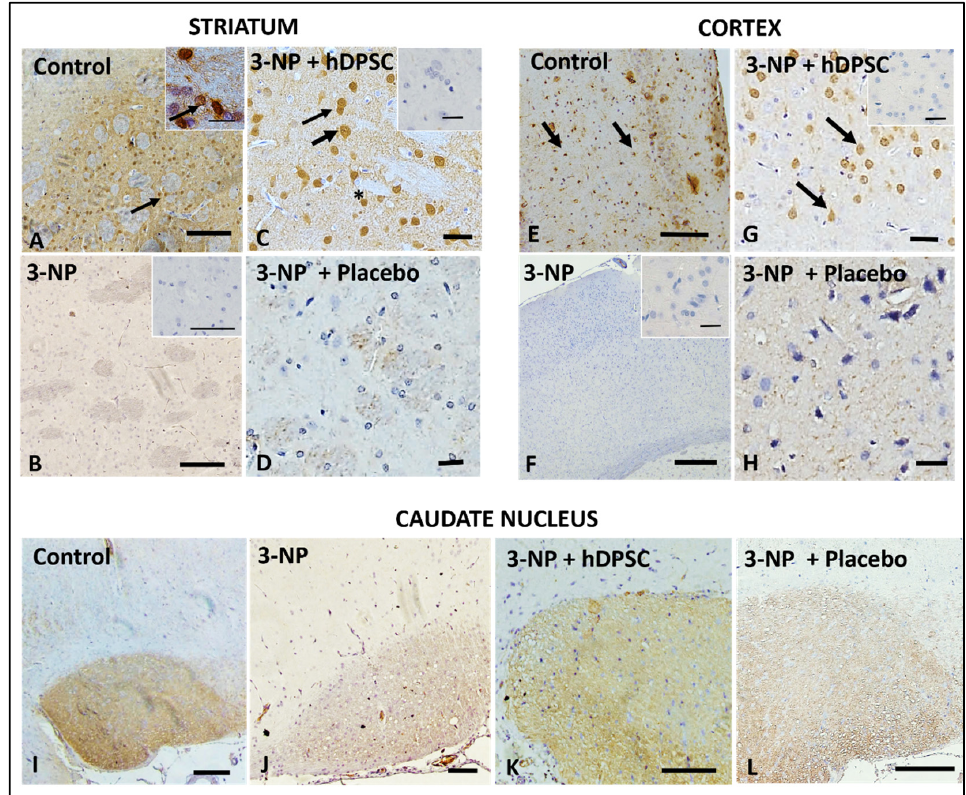
Figure 5. Expression of anti-BDNF antibody (black arrows) in the striatum ( A – D ), cortex ( E – H ) and caudate nucleus ( I – L ) in control ( A , E , I ); 3-NP ( B , F , J ), 3-NP + hIDPSC ( C , G , K ) and 3-NP + placebo animals ( D , H , L ), respectively. Insets in ( A – C , F , G ) show negative control (secondary antibody). Black arrows indicate BDNF expressing cells. Sections are contra-stained with HE. Scale bars: 50 µ m ( A , B , E , F , I – L ) and 100 µ m ( C , D , G , H ). Analysis performed 30 days after (D35) the treatment). Asterisk indicates the enlarged areas. The asterisks indicate the areas that were analyzed in